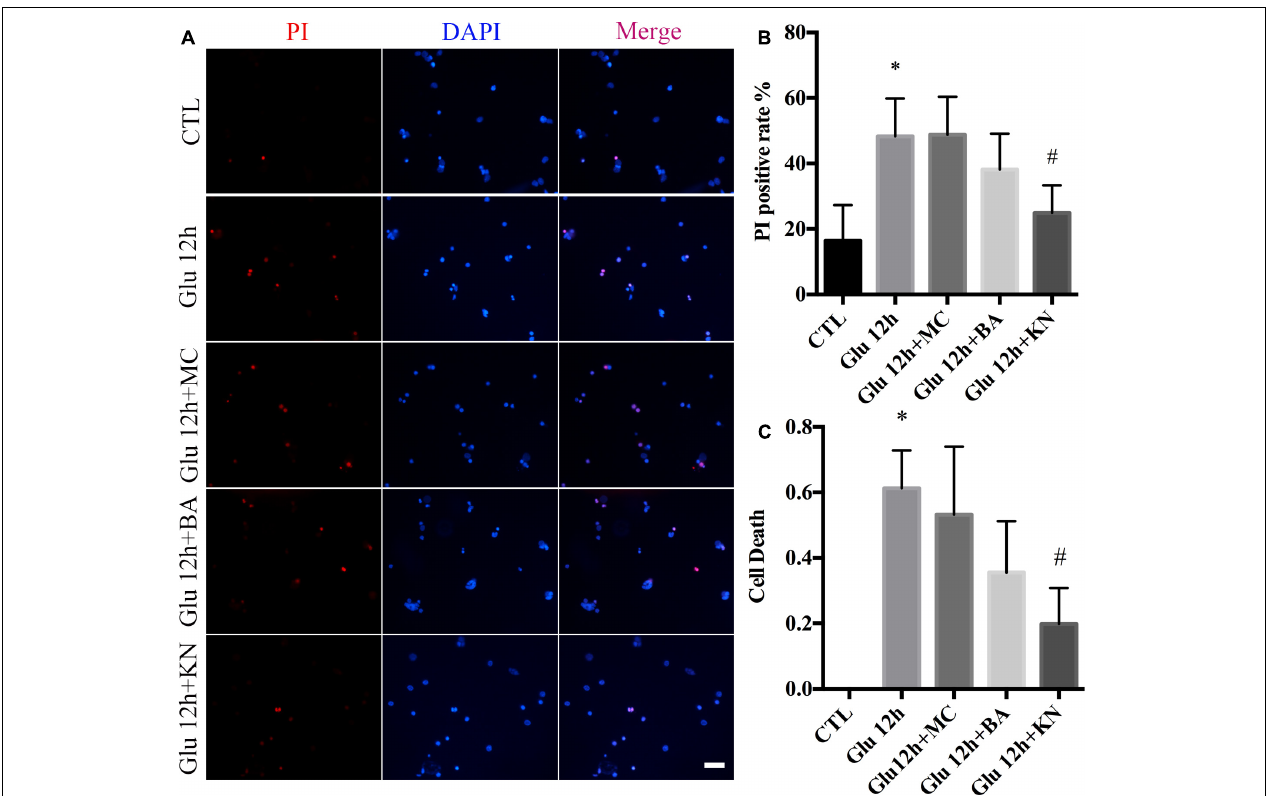
FIGURE 7 | Glutamate-induced necrosis decreased by KN treatment. (A) Retinal necrotic neurons were stained with PI (red). Nuclei were counterstained with DAPI (blue). (B) Statistical analysis of PI-positive retinal neurons. (C) The percentage of necrotic neurons after glutamate treatment and pretreated with 50 µ M MC, 10 µ M BA, and 10 µ M KN was determined by LDH release assay. N = 3 cultures. Data were analyzed using one-way ANOVA. ∗ p < 0.05 vs. CTL group, # p < 0.05 vs. Glu group. Scale bar = 20 µ m in all